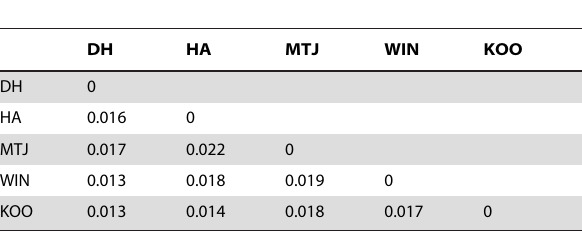
Figure 1. Schematic representation of the five Atelomastix bamfordi Banded Iron Formation populations, coloured ac- cording to the five genetic clades identified with mtDNA analysis. Black circles indicate sample sites. Study area shown in inset. doi:10.1371/journal.pone.0093038.g001 Pleistocene, between 0.729 Ma [0.532–0.952] and 1.078 Ma [0.792–1.433], although only the date of 1.078 for the divergence of the Mt Jackson population has high support (Fig. 2). Isolation and migration analysis in the program IMa2 was used to determine whether the paraphyly between Koolyanobbing and Helena Aurora was due to incomplete lineage sorting (isolation) or gene flow (migration). The three models with the highest AIC support all indicated there was no historical migration between the two populations (Table S2). Mantel tests of pairwise sequence differences against geographic distance indicated significant isolation by distance within the Koolyanobbing (r =0.740 p = 0.0001), Mt Jackson (r = 0.225 p = 0.0375) and Helena Aurora (r = 0.399 p =0.0025) populations. Population genetic structure Bayesian cluster analysis identified four genetic clusters in the microsatellite data. The first corresponded to the Die Hardy and Mt Jackson populations, and the remaining clusters to each of the three other populations (HA, WIN, KOO) (Fig. 3). Further investigation of structure in the first cluster revealed two more groupings corresponding to the separate BIF populations (DH, MTJ). There was some evidence of admixture in the Mt Jackson and Koolyanobbing populations (Fig. 3). Phylogenetic analysis of relationships between populations using Cavalli-Sforza chord distances showed distinct genetic structure amongst populations using microsatellite data, but with some clustering of Koolyanob- bing and Helena Aurora (97% bootstrap support) and Die Hardy and Mt Jackson (62%) (Fig. 4). Two of the five populations, Helena Table 2. Pairwise population nucleotide divergence based on Jukes and Cantor of five Atelomastix bamfordi populations using mtDNA